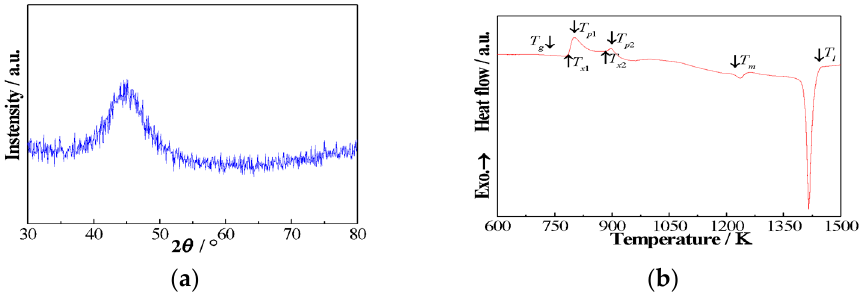
Figure 1. XRD pattern ( a ) and DSC heating curve ( b ) of the as-quenched (Fe 0.4 Co 0.6 ) 79 Nb 3 B 18 alloys.